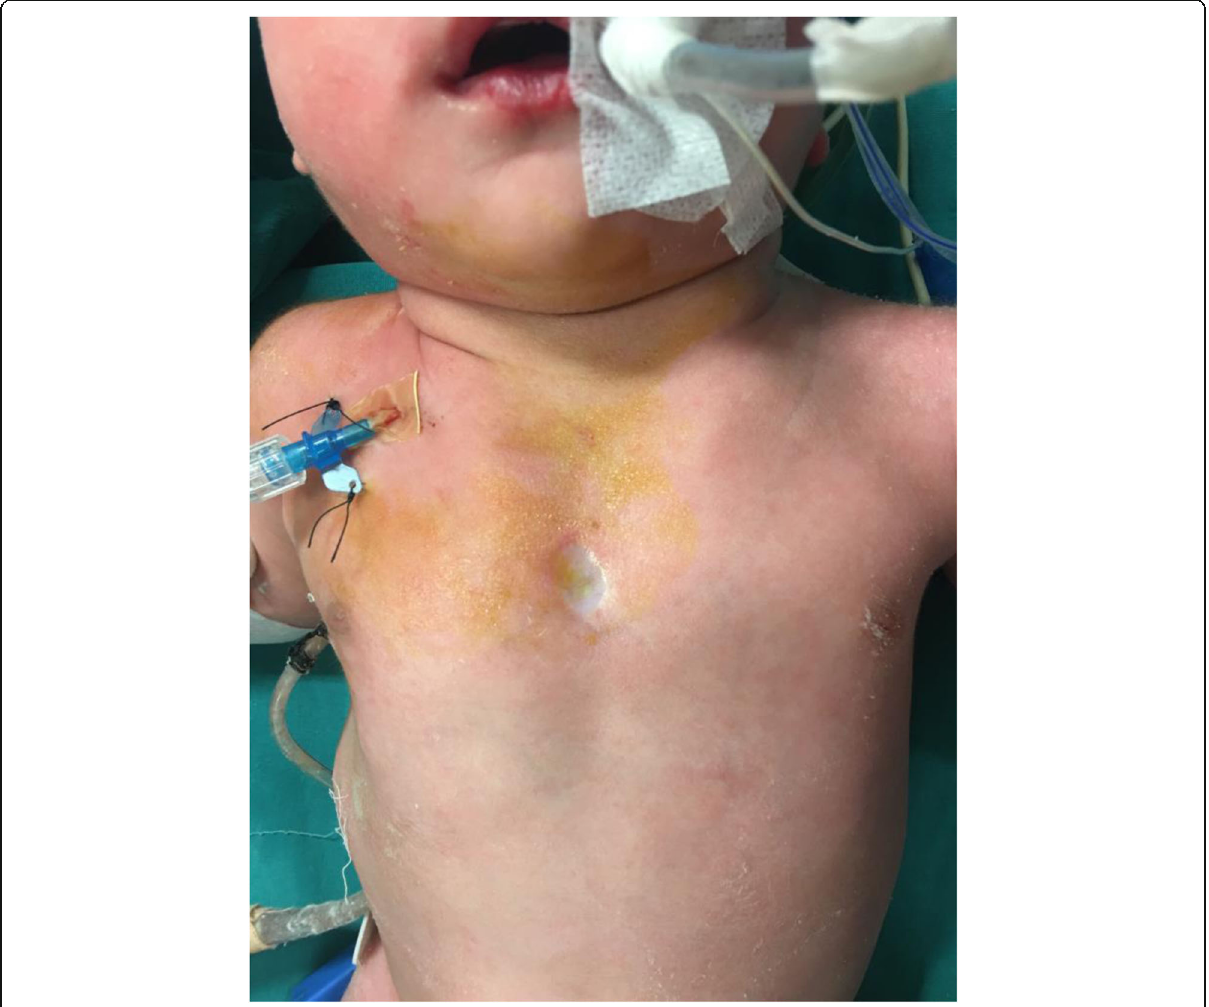
Fig. 1 On the chest midline, the superior part of the skin which is in front of the heart was fibrotic, and paradoxical respiratory movements were present in this